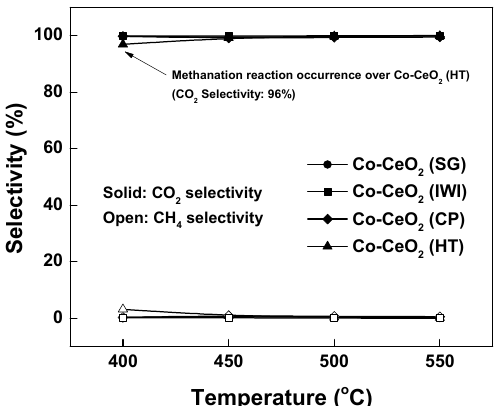
Figure 6. Selectivity to CO 2 and CH 4 with reaction temperature over Co–CeO 2 catalysts prepared by different synthetic methods (H 2 O/(CH 4 + CO + CO 2 ) = 2.0; gas hourly space velocity ( GHSV ) = 143,000 h -1 ).